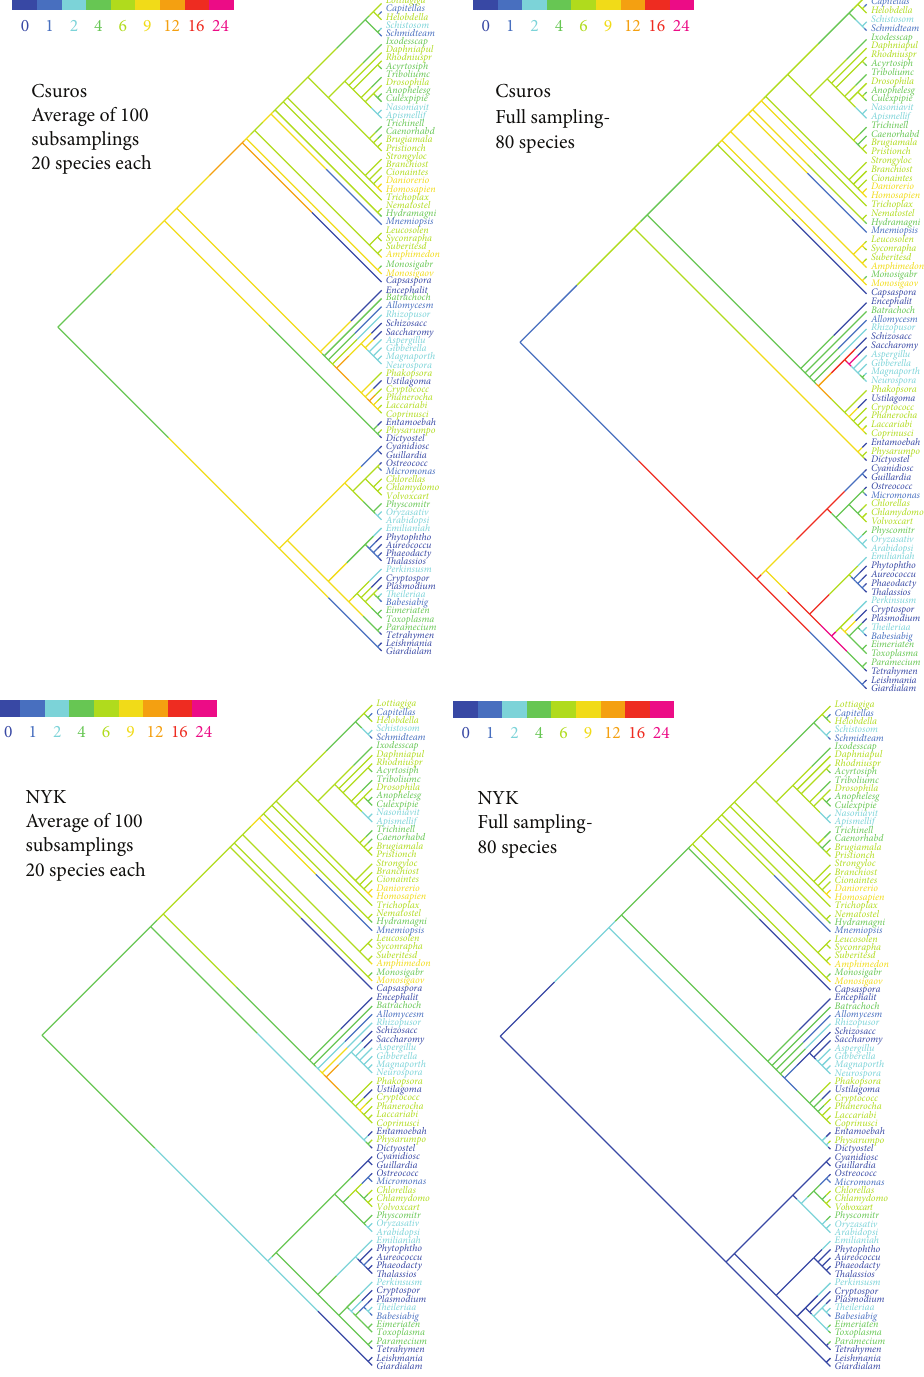
Figure 2: Examples of the intron evolution reconstructed with different taxon samplig size. The intron density on each branch (in introns/kb) is color-coded according to scale in the upper left corner. Upper row: Csuros algorithm, lower row: NYK algorithm. Left column: averaged intron densities using 100 subsets of 20 species each. Right column: full set of 80